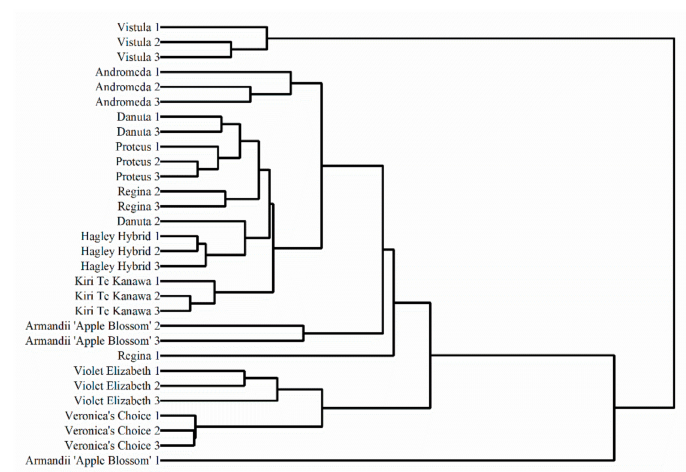
Figure 8. Dendrogram of Vistula, Andromeda, Danuta, Armandii ‘Apple Blossom,’ Proteus, Hagley Hybrid, Violet Elizabeth, Kiri Te Kanawa, Regina, and Veronica’s Choice based on the voltammograms recorded after two solvent extractions under two buffer solution